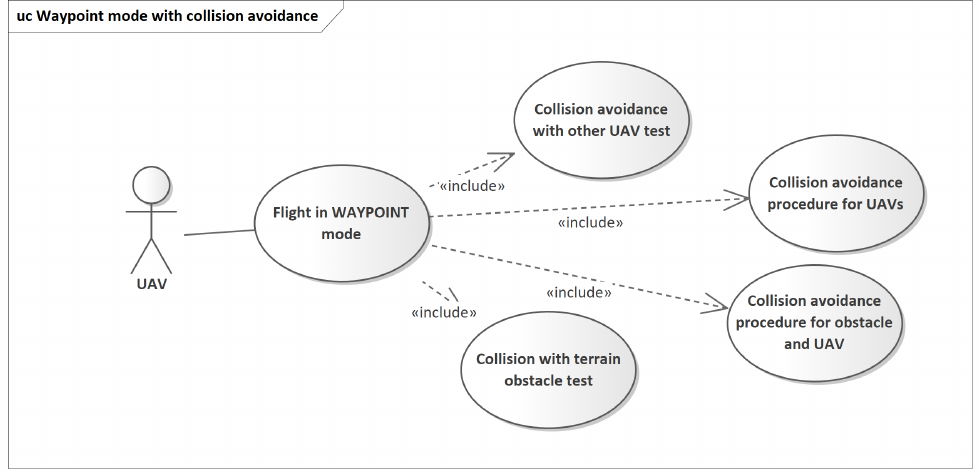
Figure 1. Use case scenario: UAV flight in WAYPOINT mode [27]. UAV can perform a flight in a WAYPOINT mode with the handling of exceptional